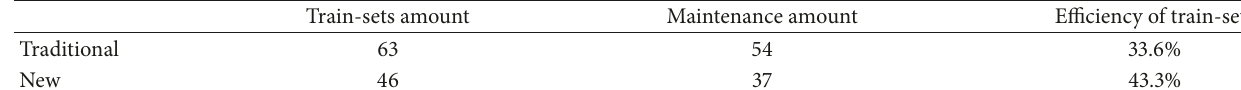
Table 6: Comparison of two maintenance modes.